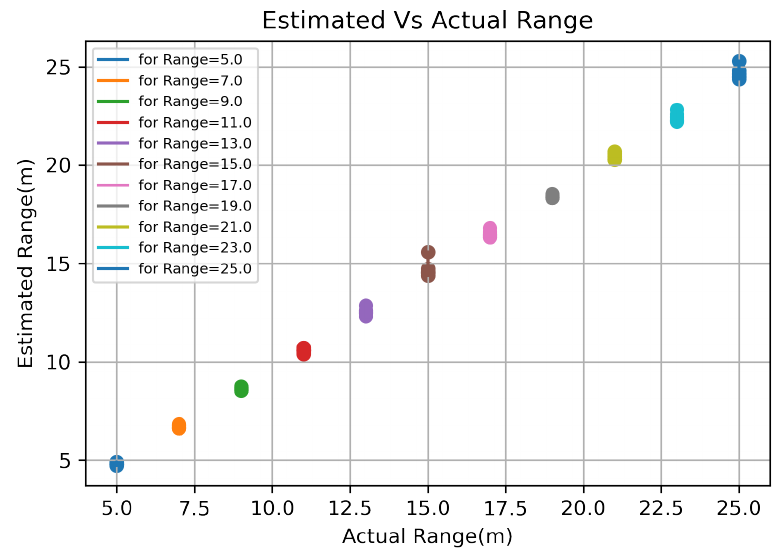
Figure 10. Graph showing estimated value vs. actual value of ranges.